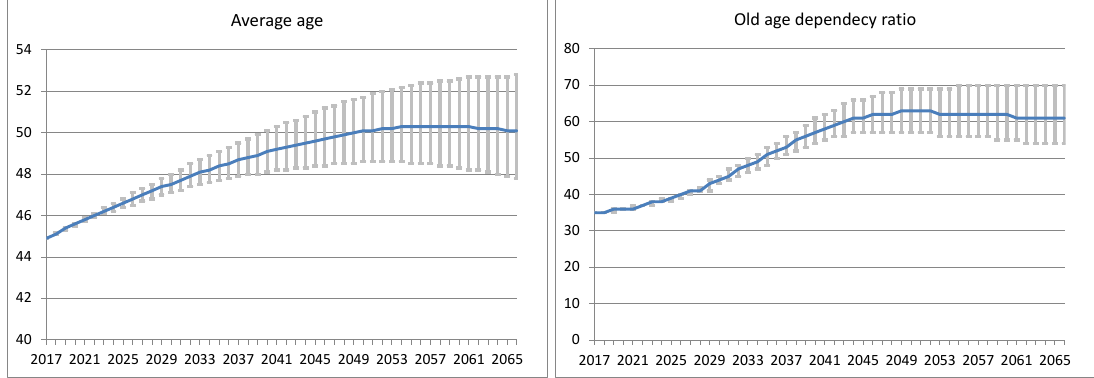
Figure 2. Estimated aging trend in Italy as per the Italian National Institute of Statistics (ISTAT). Estimates are shown within 90% confidence